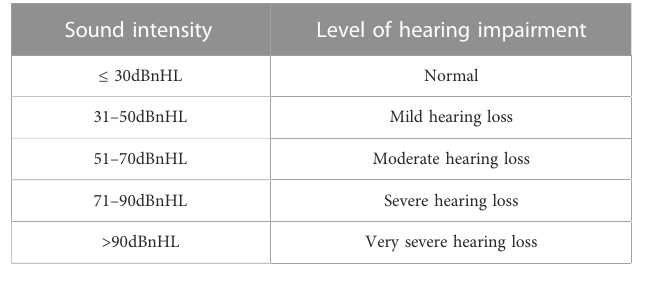
TABLE 1 Hearing loss in children under 2 years of age level of hearing loss.